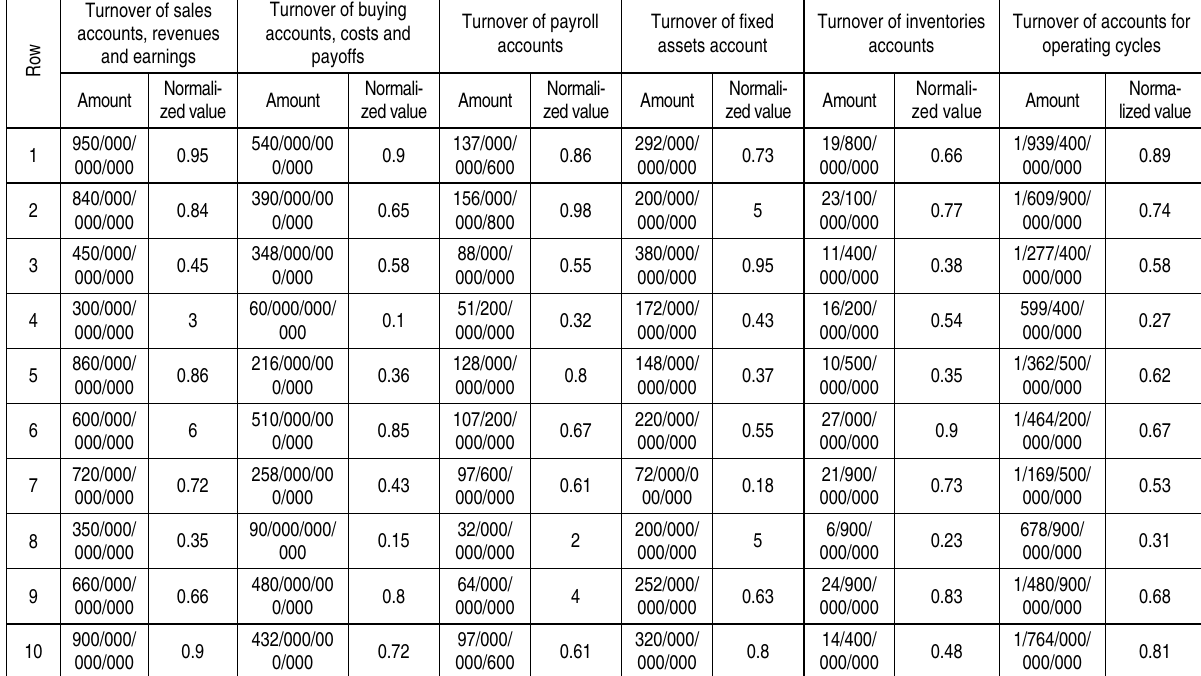
Table 8. Turnover of accounts in respect of operating cycles at 10 sample